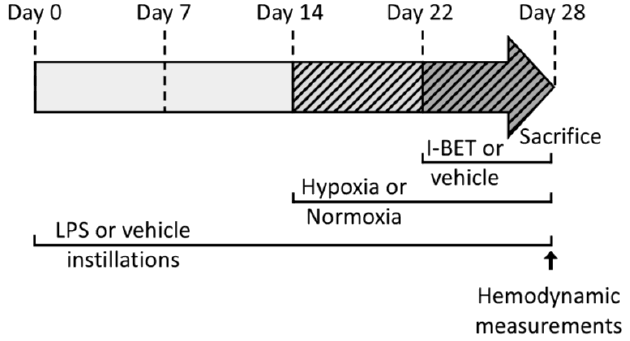
Figure 5. Chronogram of experimental protocol. I-BET: Inhibitor of Bromodomains and Extra-Terminal domains; LPS: Lipopolysaccharides. LPS or its vehicle instillations were performed for 28 days. For